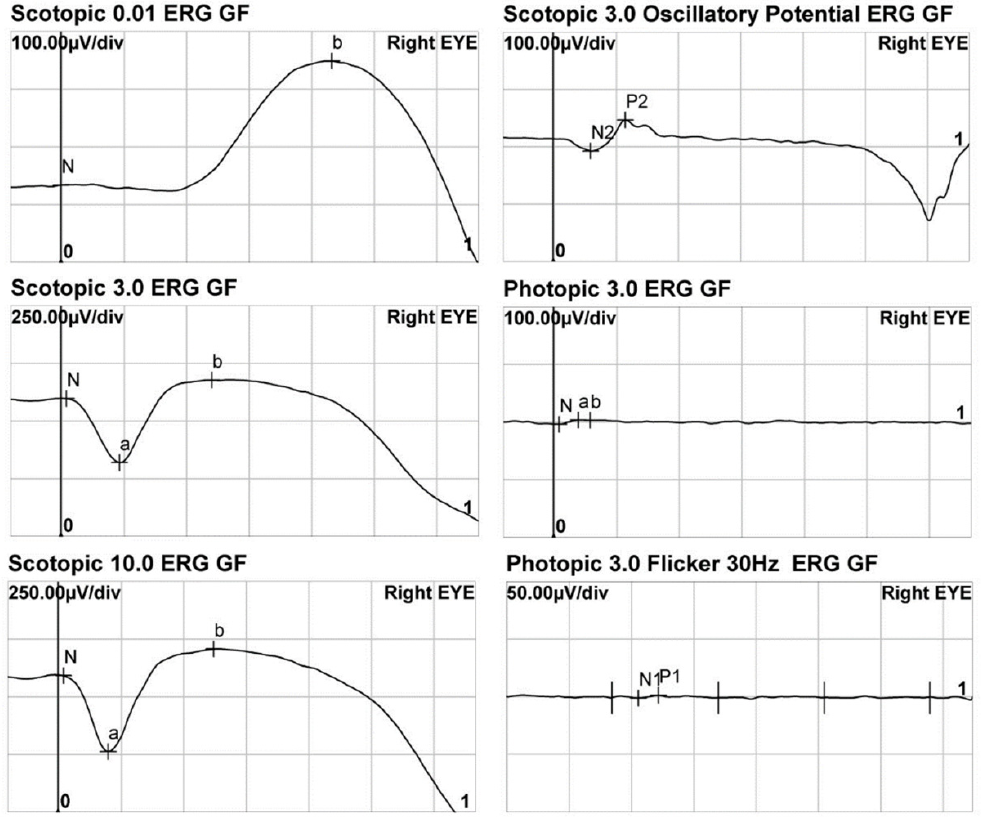
Figure 3. A representative result of the electroretinogram (ERG) obtained from patient #1. While almost no photopic responses were observed, scotopic responses were normal.